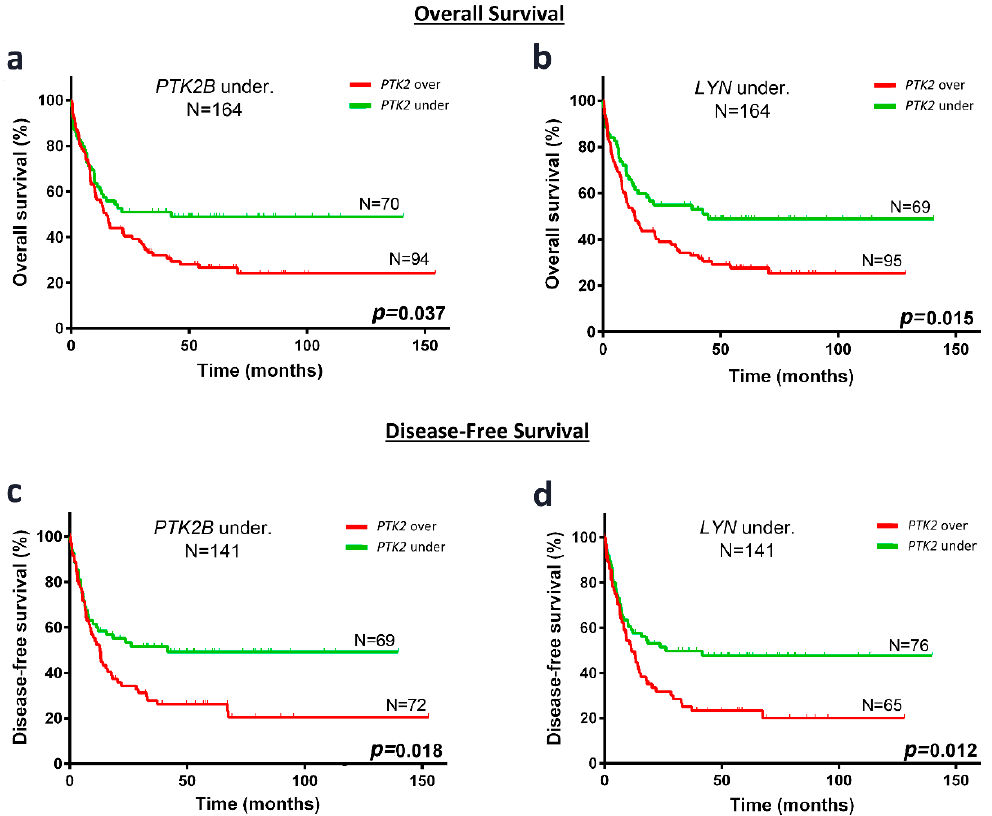
Figure 5. PTK2 overexpression associates with poor OS or DFS in cytogenetic IR-AML patients with non-favorable FLT3/NPM1 combinations that underexpress PTK2B or LYN. Kaplan-Meier curves represent survival depending on the PTK2 expression in PTK2B ( a ; OS, c ; DFS) or LYN ( b ; OS, d ; DFS) underexpressed patients. Black line and gray line indicate PTK2 overexpressed and underexpressed, respectively. Log-rank test for OS and DFS were used to analyze the statistical significance. p < 0.05 was considered statistically significant (bold values).